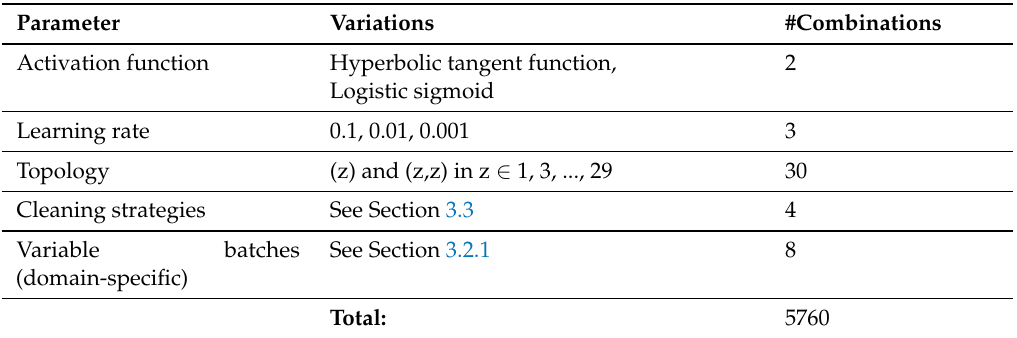
Table 6. Parameter combinations used for the ANN models. Each value is separated by a comma. The topology (z) and (z,z), indicate one and two layers with z nodes in each layer, respectively. Each combination of parameters represents one model